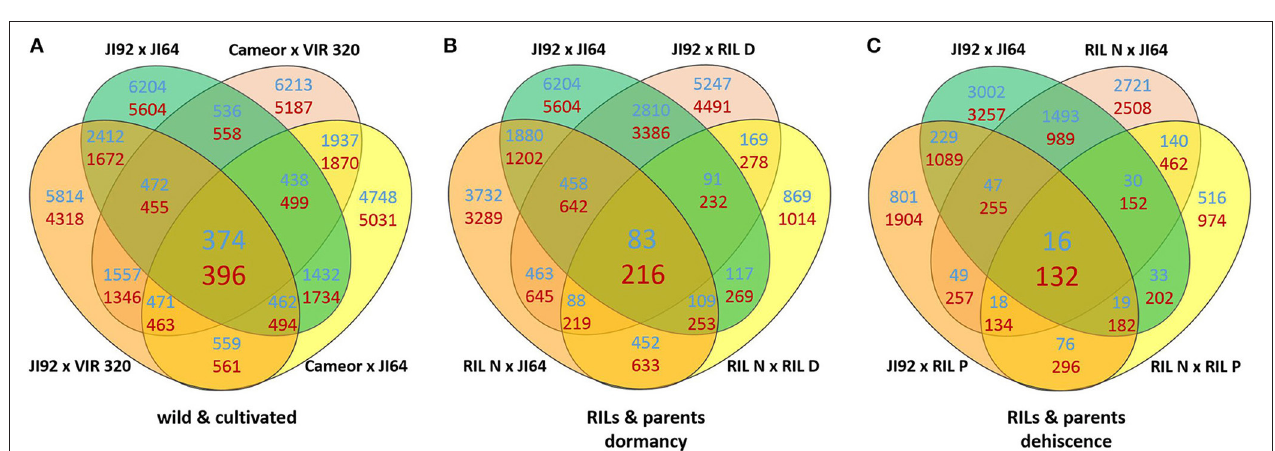
FIGURE 6 | LDI-MS analysis of dihydroxyheptacosanoate (A) and dihydroxyoctacosanoate (C) in seed coats of contrasting parents (JI64, JI92) and selected RILs (intensity of signals at particular m/z-values normalized to sum of all signals in mass spectrum; red, non-dormant; blue, dormant lines; error bars reflect the standard deviation of three replicated measurements, α = 0.05); (B,D) , zoomed graphs.